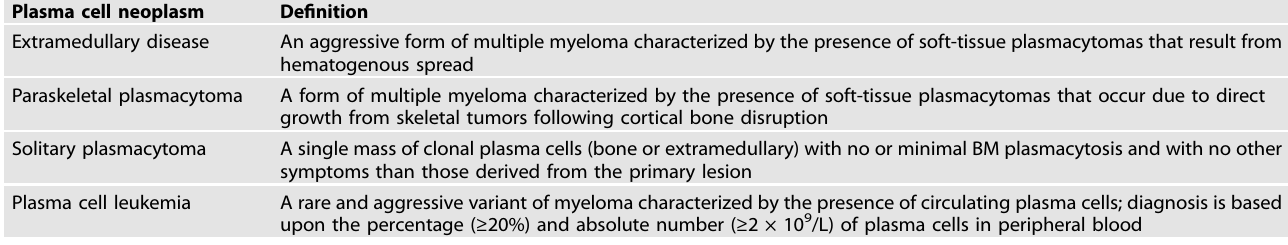
Table 1. De fi nitions of plasma cell